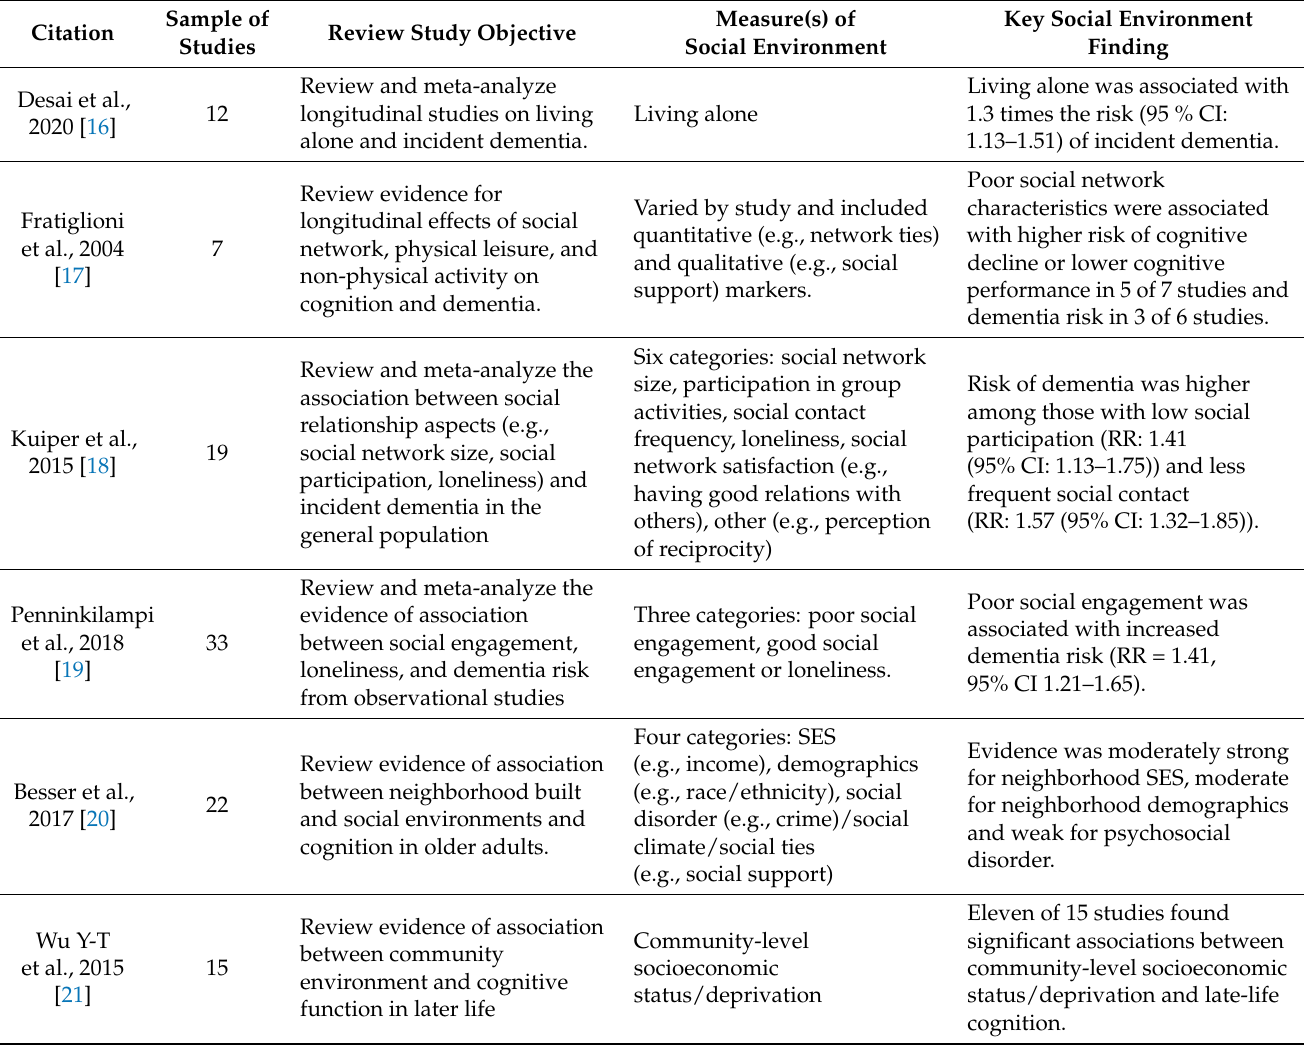
Table 2. Social environment measures and social ecological level for systematic review studies that met inclusion criteria.